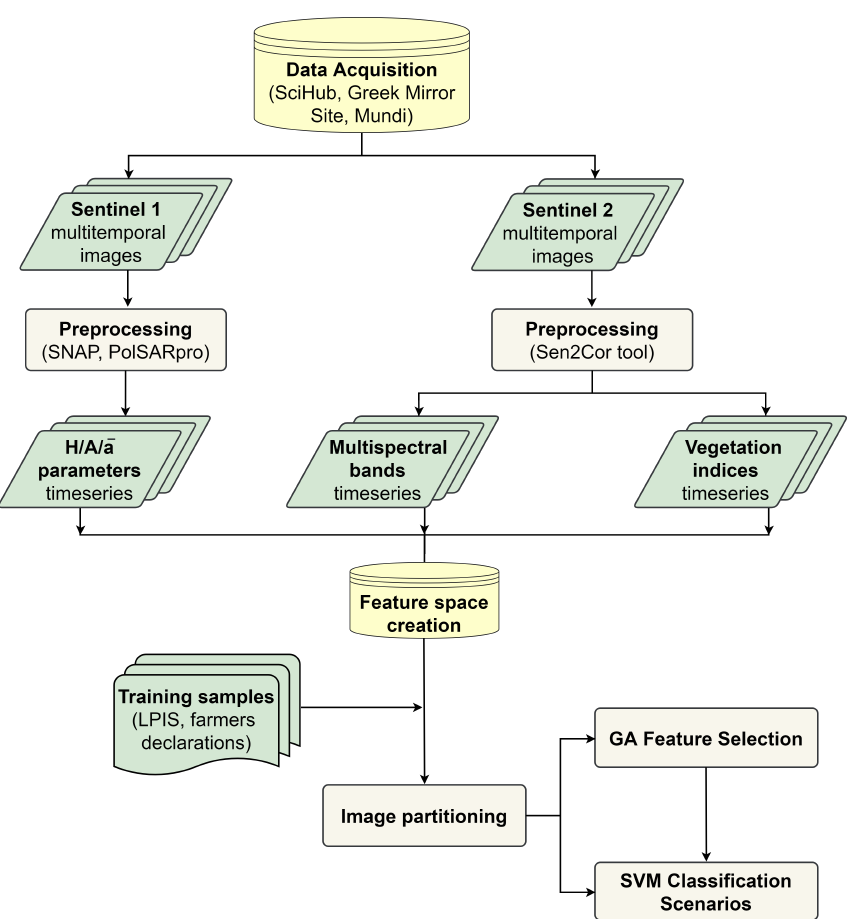
Figure 4. The methodological workflow of this